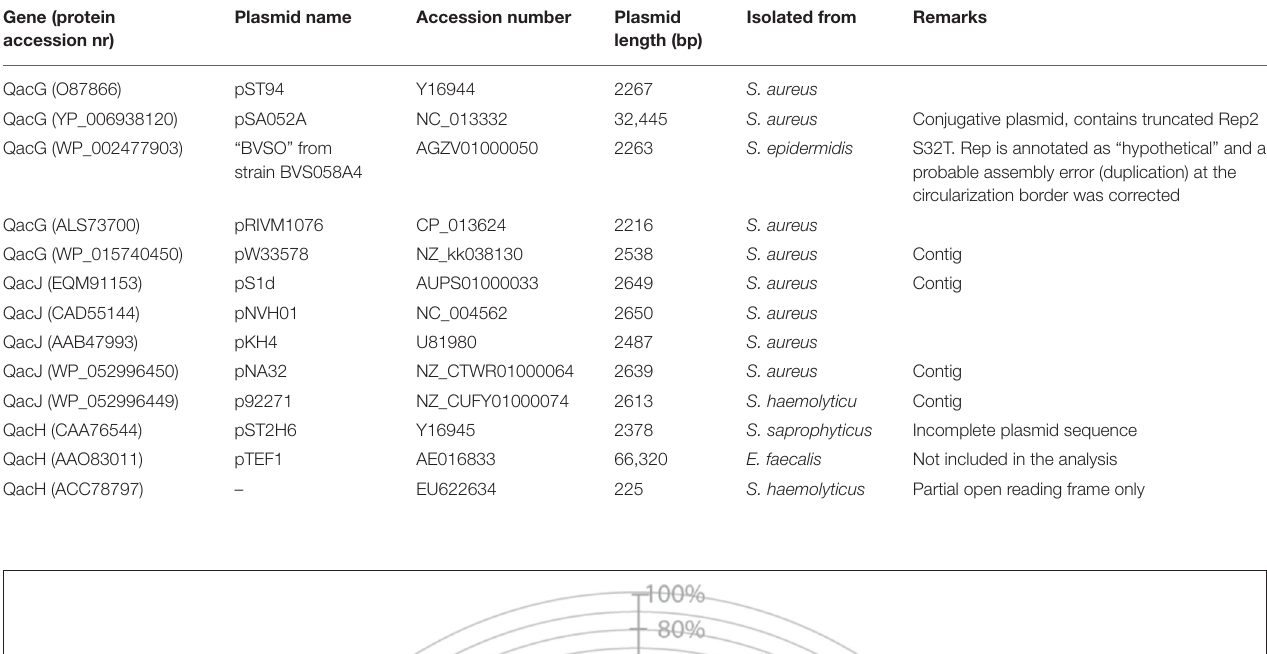
TABLE 2 | Plasmids containing QacG, QacJ, or QacH used in the analysis.